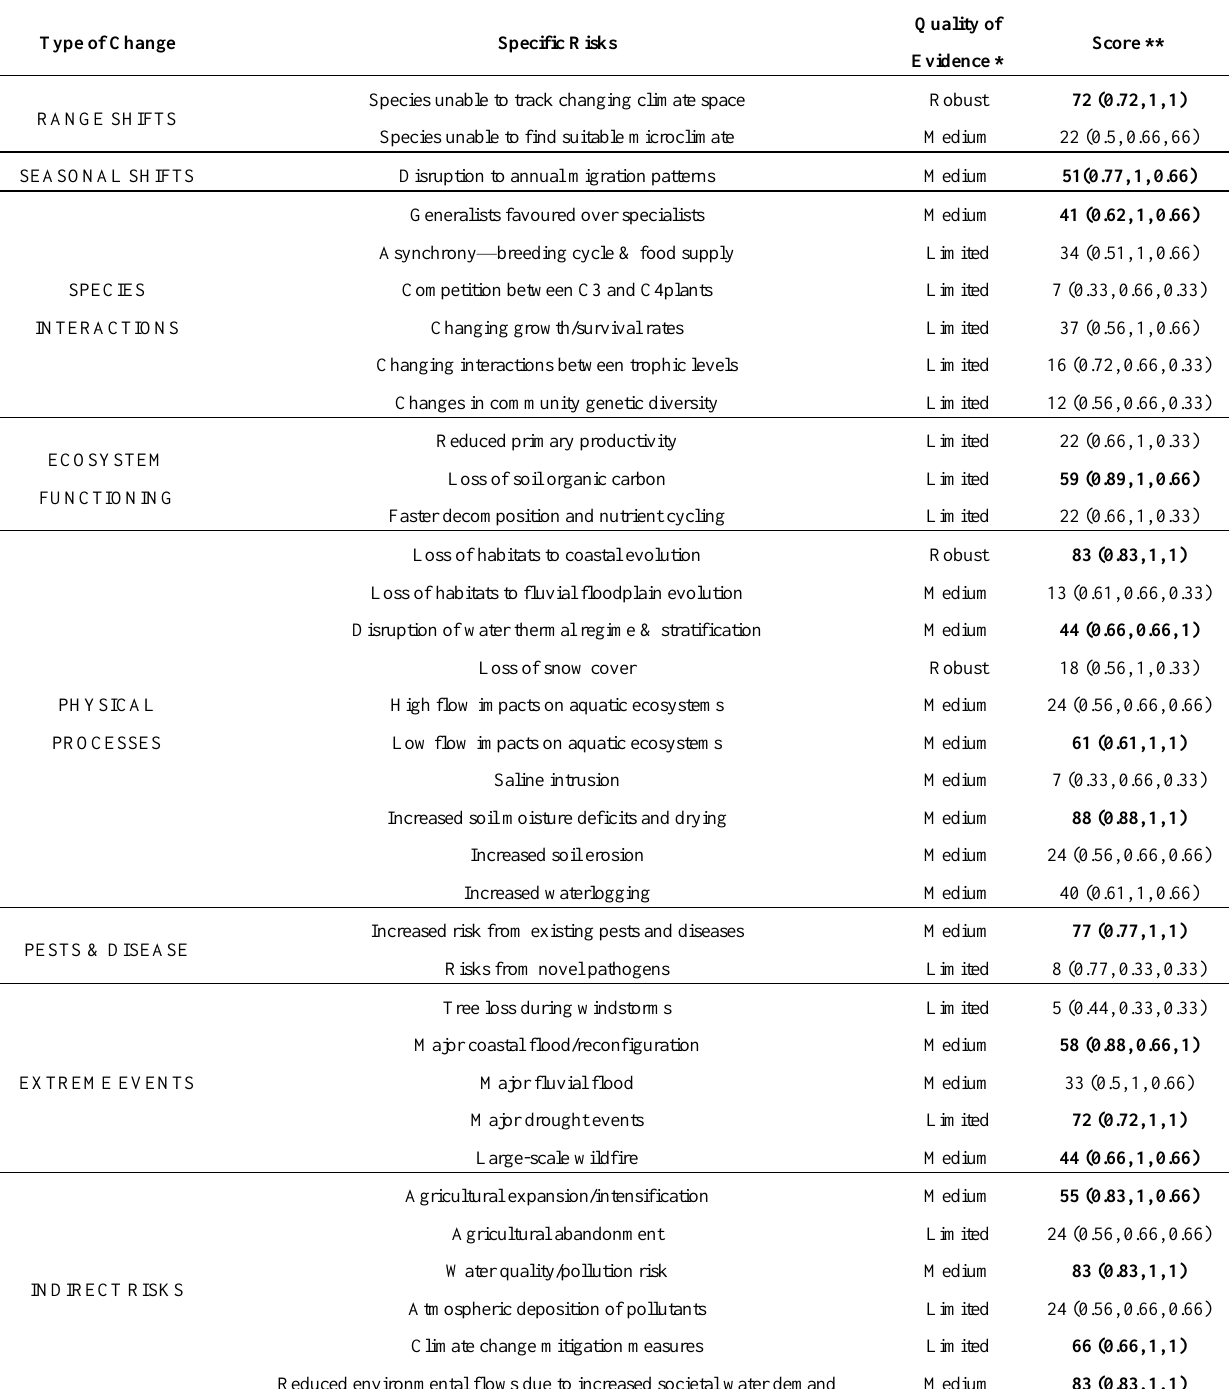
Table 2. Climate risks evaluated for the natural environment.